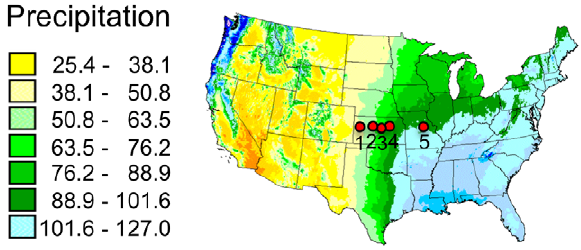
Figure 1. Location of prairies sampled across a significant precipitation gradient in the Great Plains. Prairie locations are (1) Smoky Valley Ranch, (2) Wilson Lake, (3) The Land Institute, (4) Konza Prairie Biological Station, and (5) Tucker Prairie. The background shading indicates an interpolation of annual average precipitation (cm) from 1961–1990 (where the precipitation map is copyright PRISM Climate Group, Oregon State University, http://prism.oregonstate.edu).